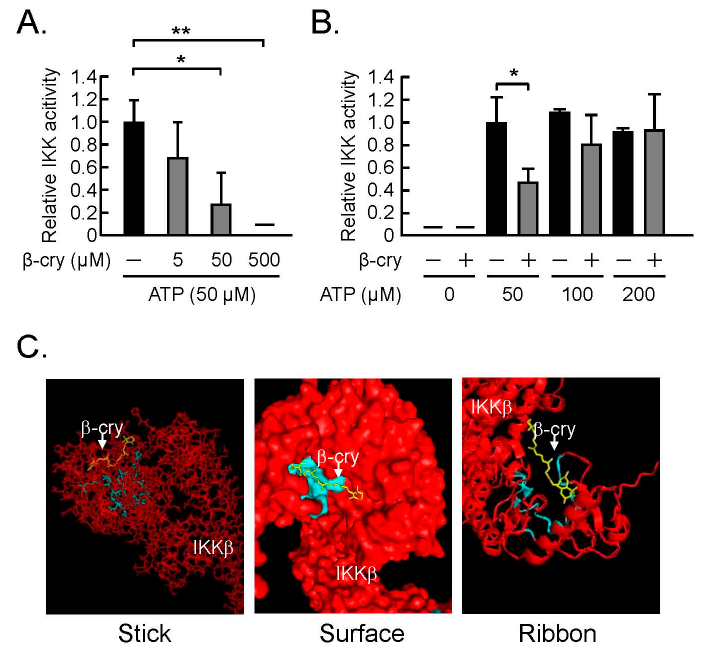
Figure 3. The direct action of β -cry on inhibitor of NF- κ B kinase (IKK) activity in an in vitro assay.